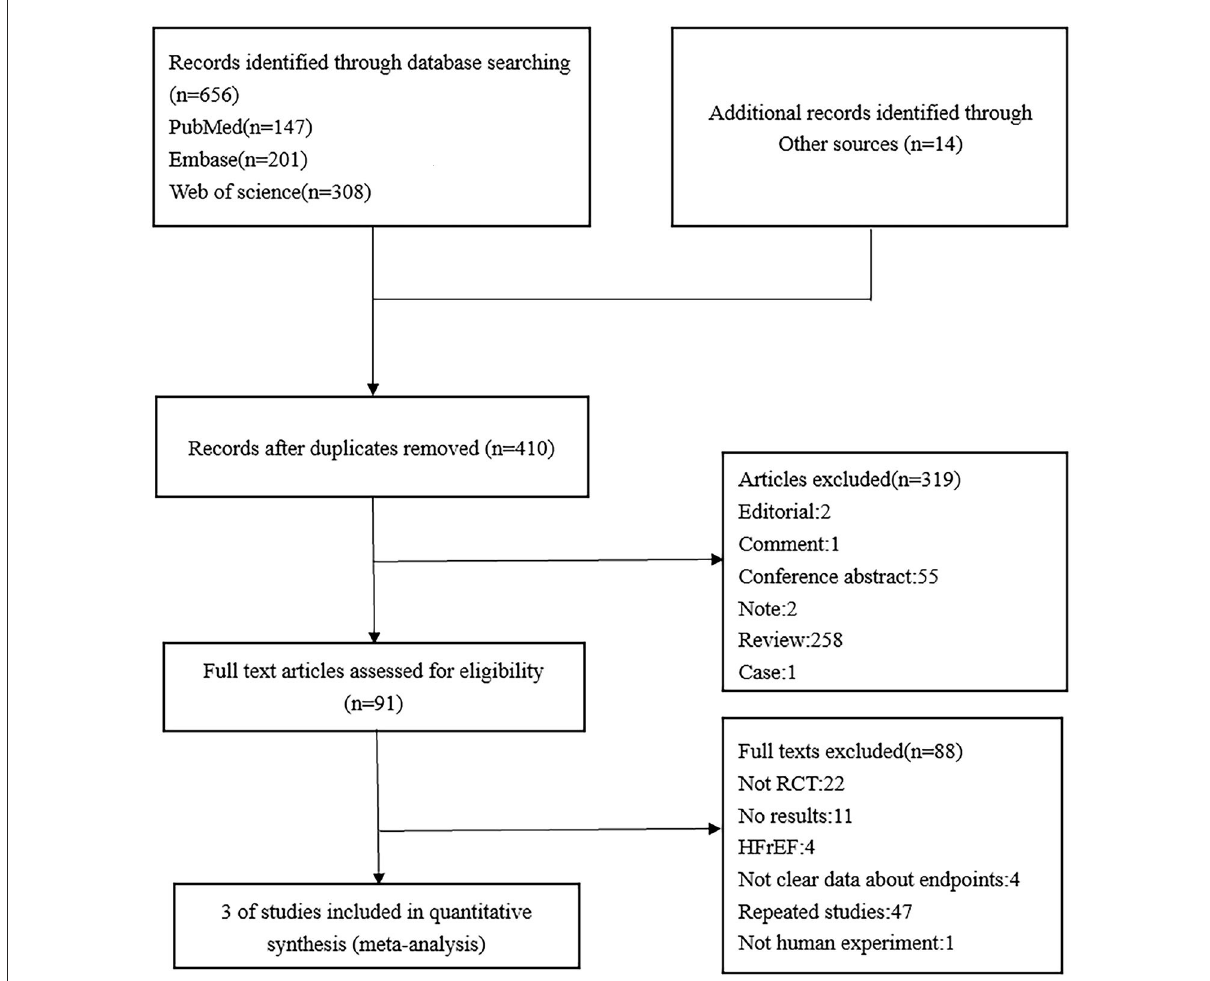
Angioedema The results showed that patients